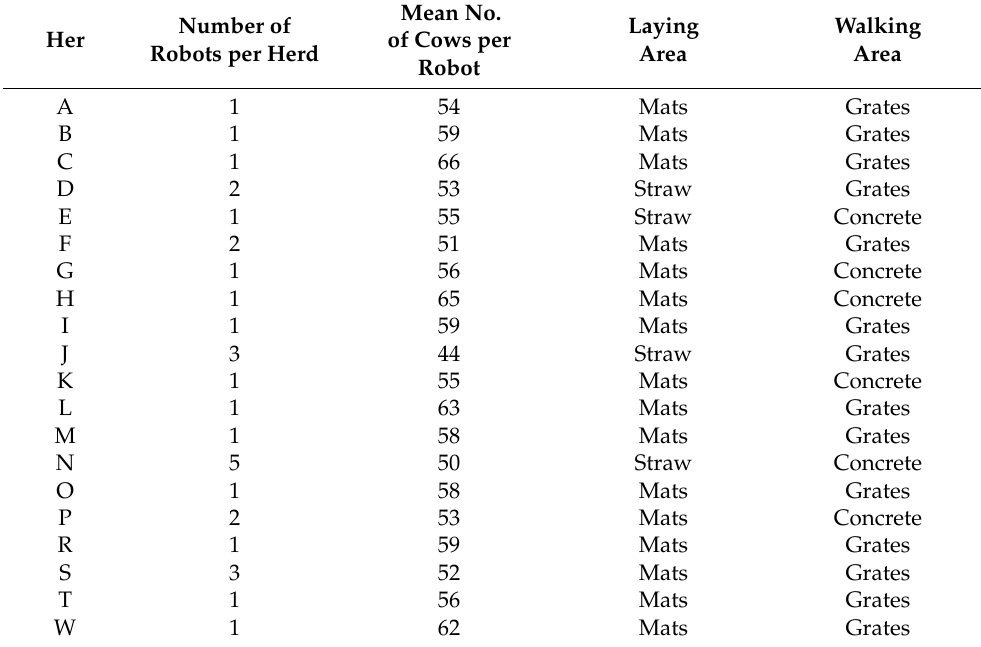
Table 1. Characteristics of studied dairy herds milked with automatic milking